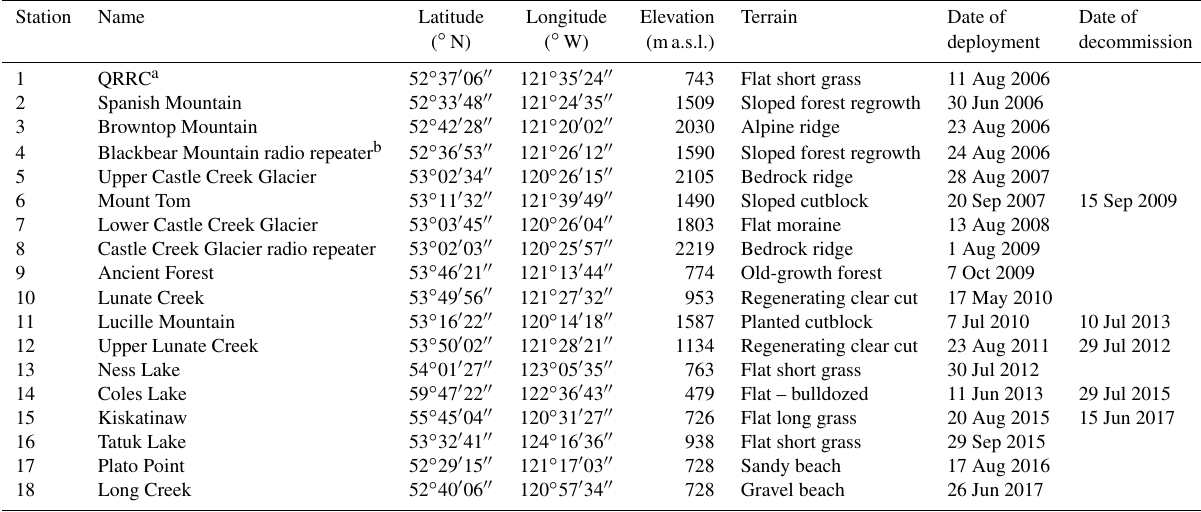
Table 1. Details for each CAMnet